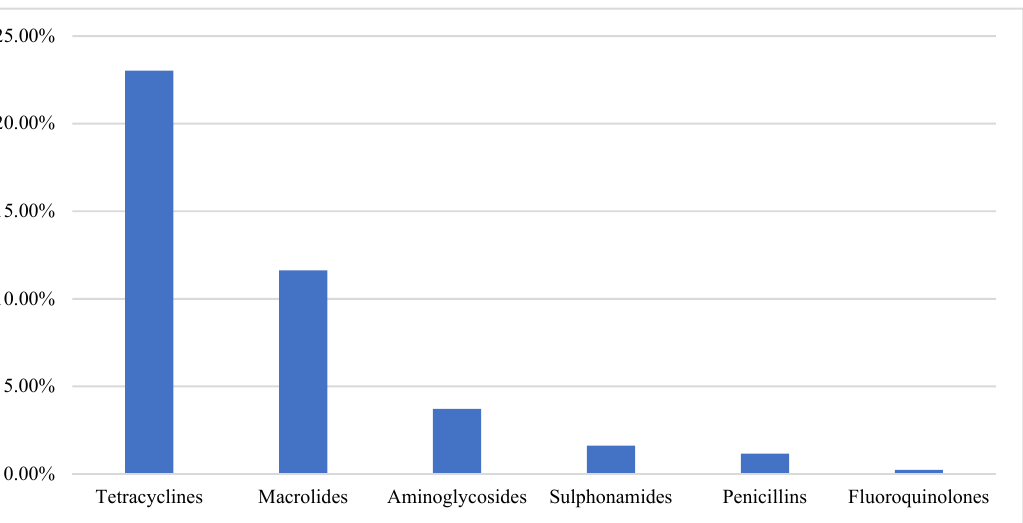
Figure 2. Antibiotic classes used on chicken farms in the past month. Respondents reported using tetracyclines four times or more in the month ( n = 95, 43.98%). Similarly, 59 respondents described using macrolides 3 times or more in the month, however 133 (61.86%) reported not using macrolides at all in the last 4 weeks. As for the vitamin/iron supplements, 182 (84.25%) respondents used them at least once a